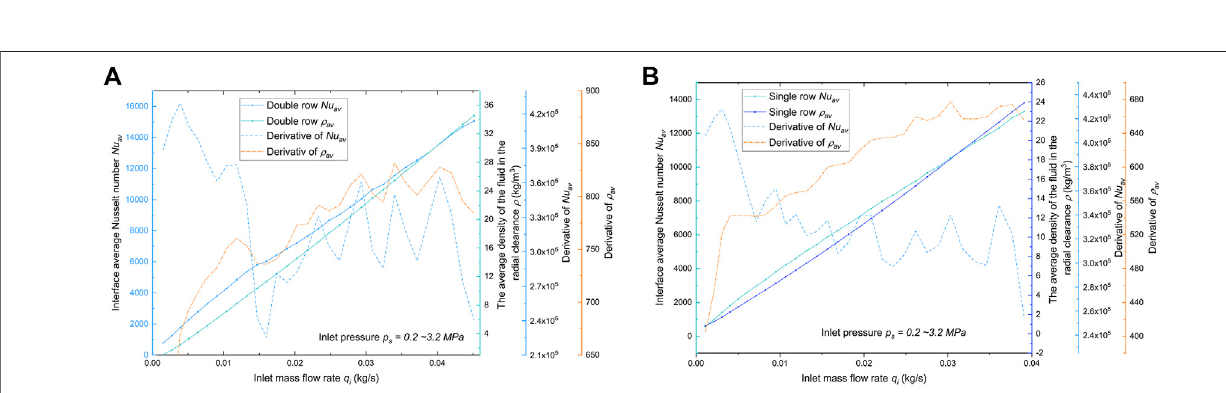
FIGURE 4 | Factors affecting heat transfer ef fi ciency: the average Nusselt number Nu av at the interface, the average density ρ av of the gas in the radius clearance and their derivatives with respect to the mass fl ow rate q i , versus q i . (A) Double row, (B) Single row.